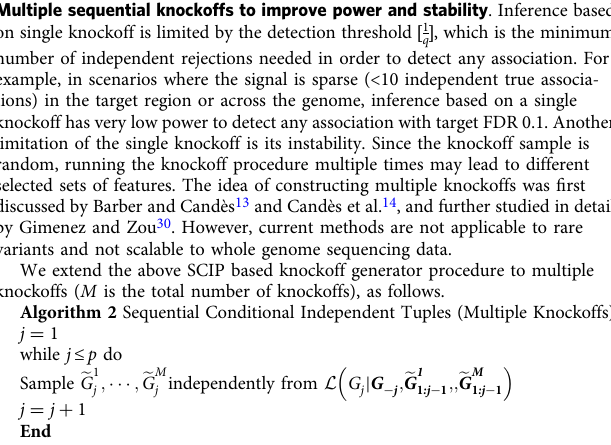
Algorithm 1 Sequential Conditional Independent Pairs (Single Knockoff) j ¼ 1 while j ≤ p do